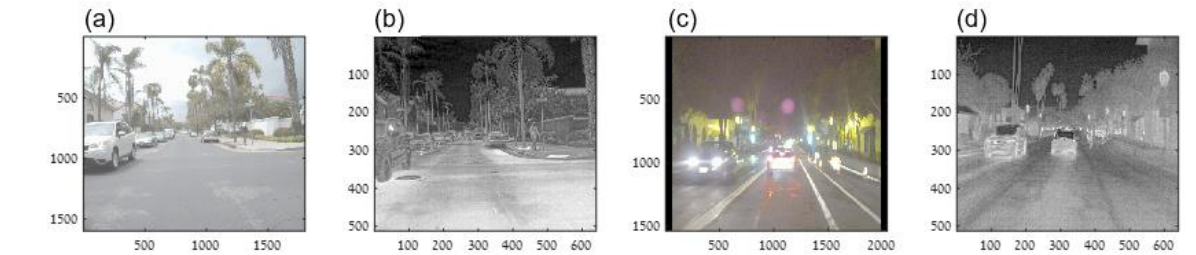
Figure 1. Example of FLIR dataset dual image: ( a ) FLIR_02767 RGB image size 1600 × 1800 × 3; ( b ) FLIR_02767 IR image size 512 × 640; ( c ) FLIR_05563 RGB image size 1536 × 2048 × 3; ( d ) FLIR_05563 IR image size 512 × 640.